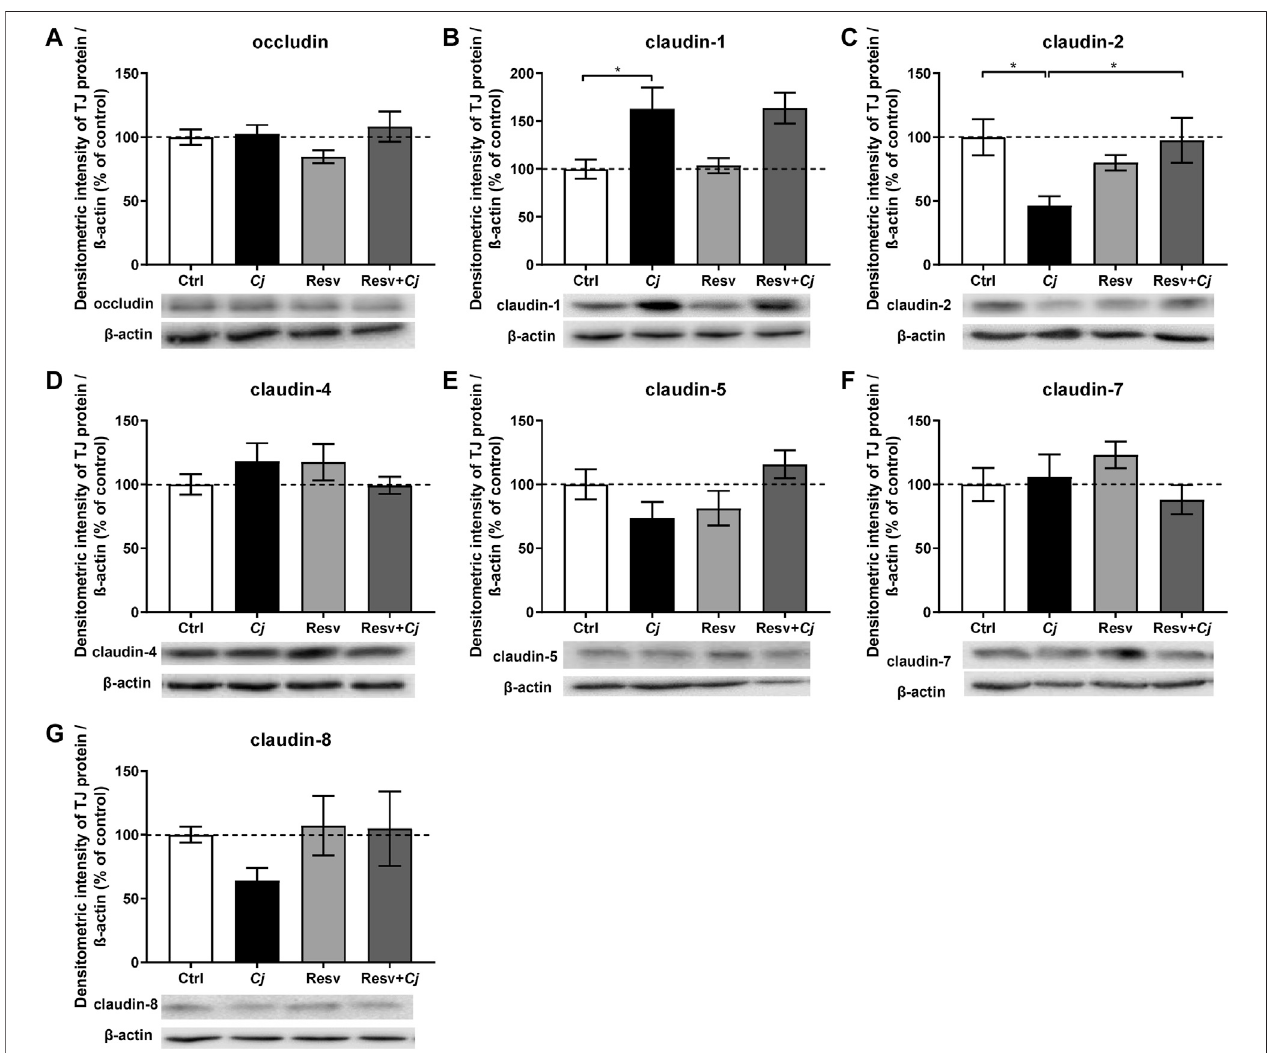
FIGURE 2 | Expression of tight junction proteins after Campylobacter jejuni infection and resveratrol treatment. Epithelial tight junction protein expression changes under C. jejuni ( Cj ) infection and resveratrol (Resv) treatment in vitro . Proteins from HT-29/B6-GR/MR cell monolayers were isolated after 48 h C. jejuni infection with or without 100 µM resveratrol treatment for protein expression analysis by Western blotting (A) occludin (B) claudin-1 (C) claudin-2 (D) claudin-4 (E) claudin-5 (F) claudin- 7, and (G) claudin-8 expression were quanti fi ed by densitometric analysis of Western blots, normalized to β -actin. Untreated uninfected cells were set as controls (Ctrl) at 100% ( n (cid:2) 5 – 10, * p < 0.05, one-way ANOVA with Bonferroni